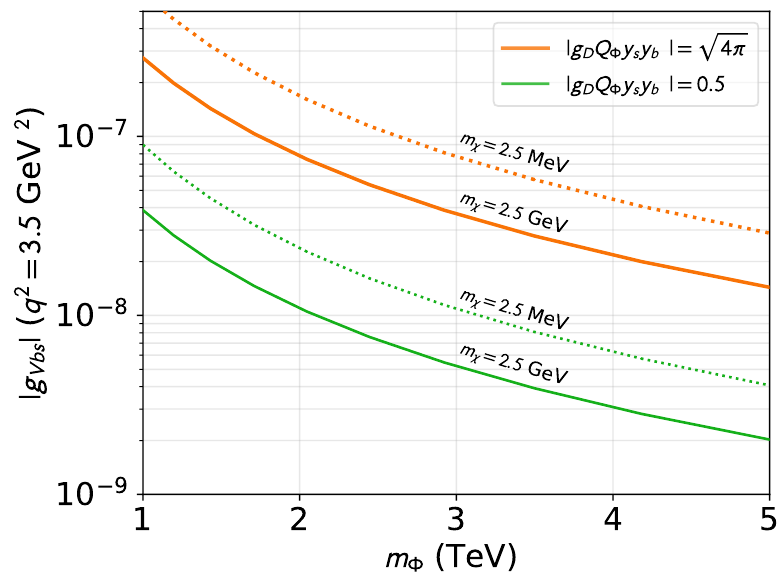
Figure 2 . The typical size of g V bs as a function of the heavy mass m (cid:8) for di(cid:11)erent choices of the e(cid:11)ective coupling j g D Q (cid:8) y i (cid:3) y i j given here for one light dark fermion, (cid:31) 1 . Solid (dashed) lines s b correspond to m (cid:31) = 2 : 5 GeV(MeV). Indicative momentum transfer is set at q 2 = 3 : 5 GeV 2 1